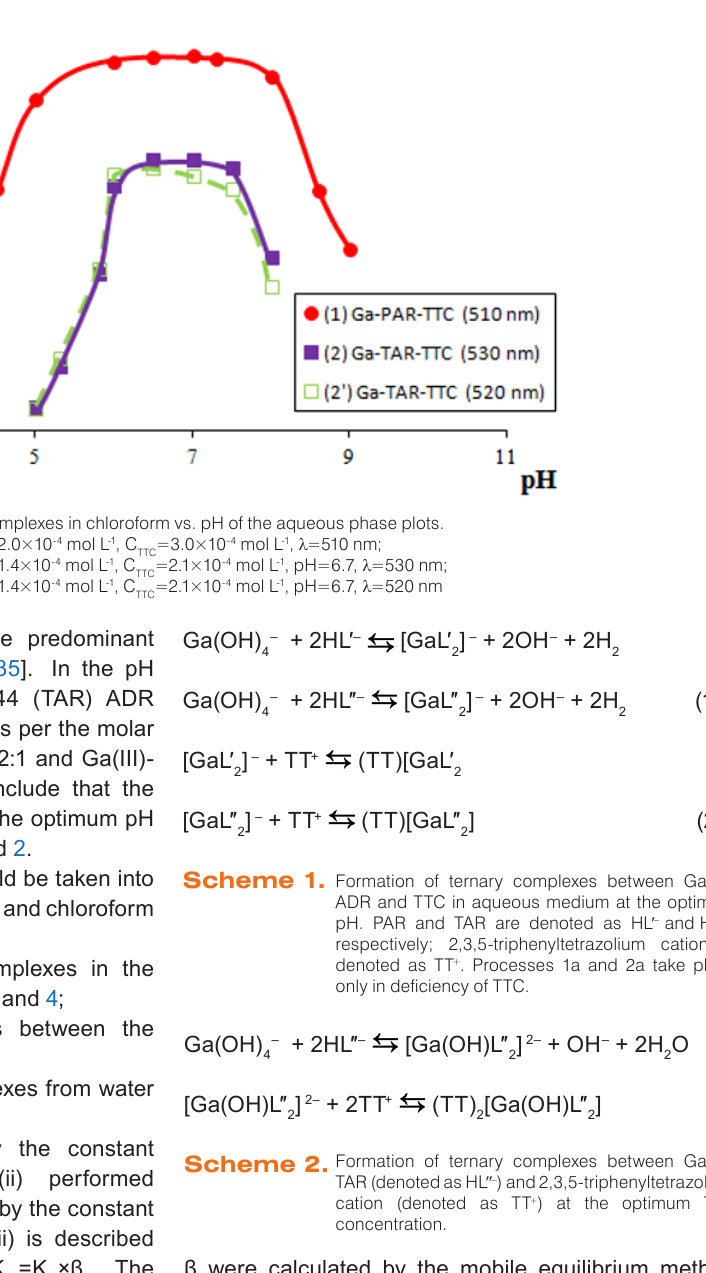
(Fig. 5) [34], the method of Komar and Tolmachev (Fig. 6) [33], and the method of Holme-Langmihr [37].